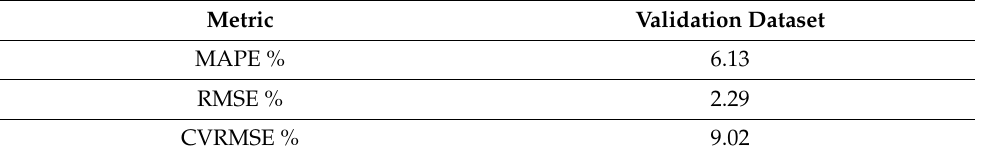
Table 5. Statistical performance metrics of the SVM model with Bayesian optimization for the validation